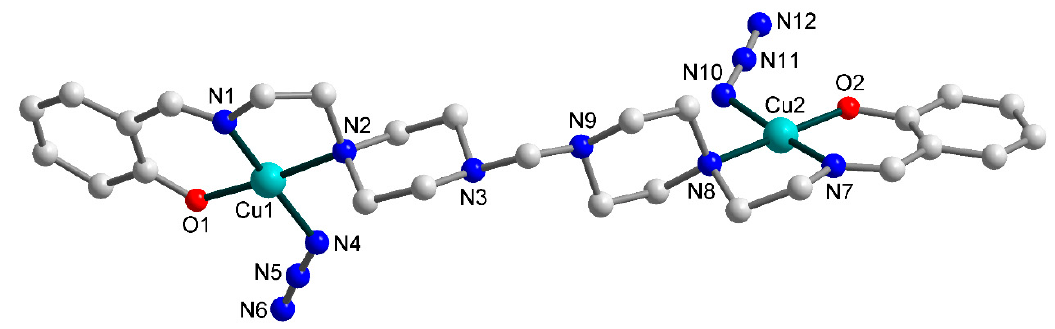
Figure 5. Molecular structure of 2 (building unit) showing the atom numbering. H atoms and uncoordinated water molecule are omitted for clarity. Colour scheme: Cu, cyan; O, red; N, blue; C, grey.